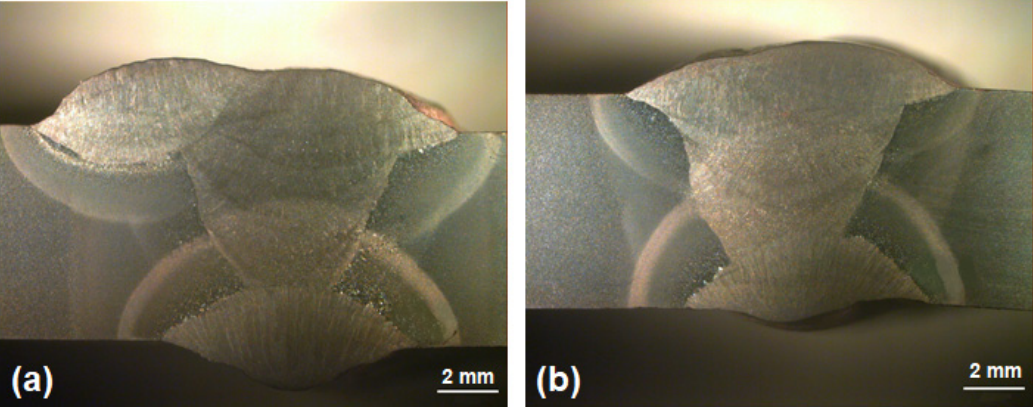
Figure 7. Macroscopic transversal section of welded steel: ( a ) with higher heat input; ( b ) with lower heat input.